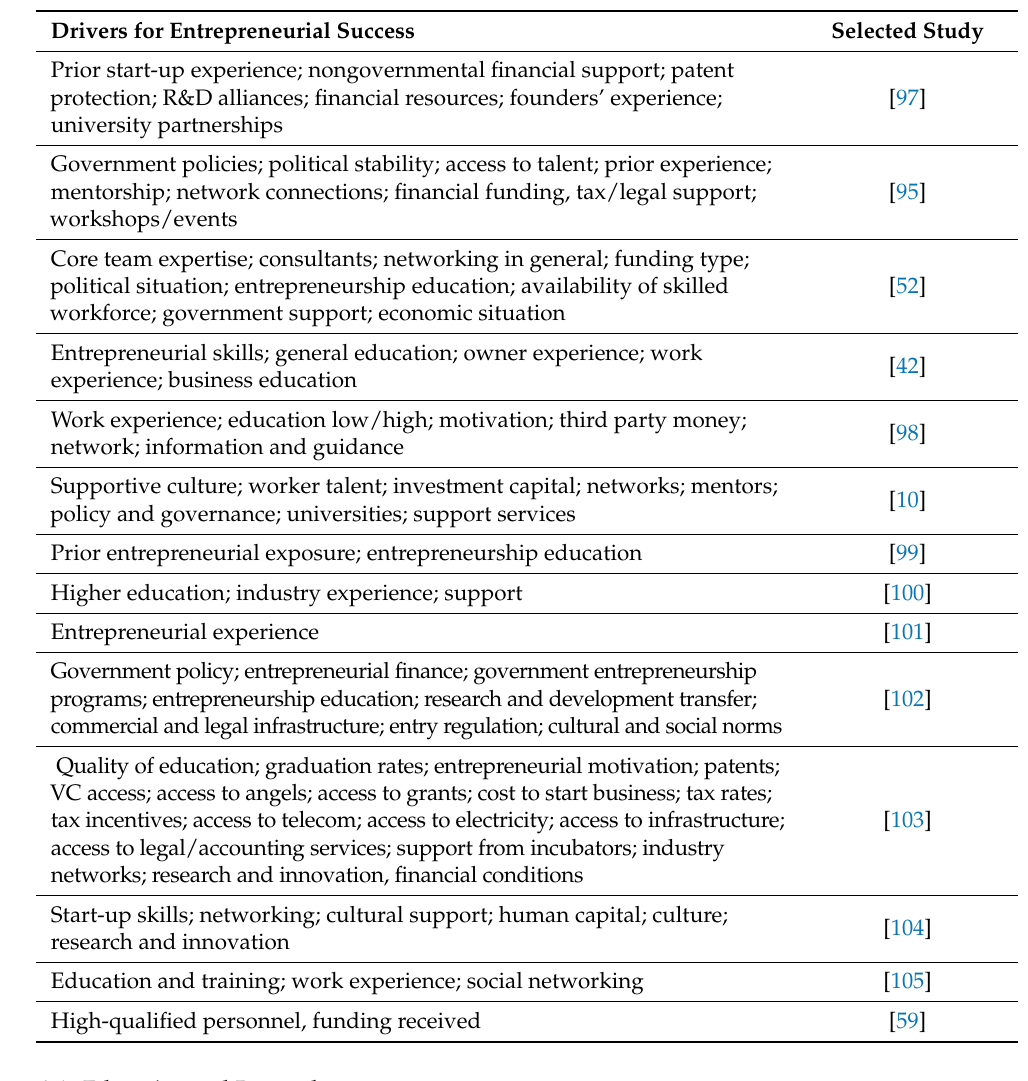
Table 2. Contextual factors as identified from the literature. Drivers for Entrepreneurial Success Selected Study